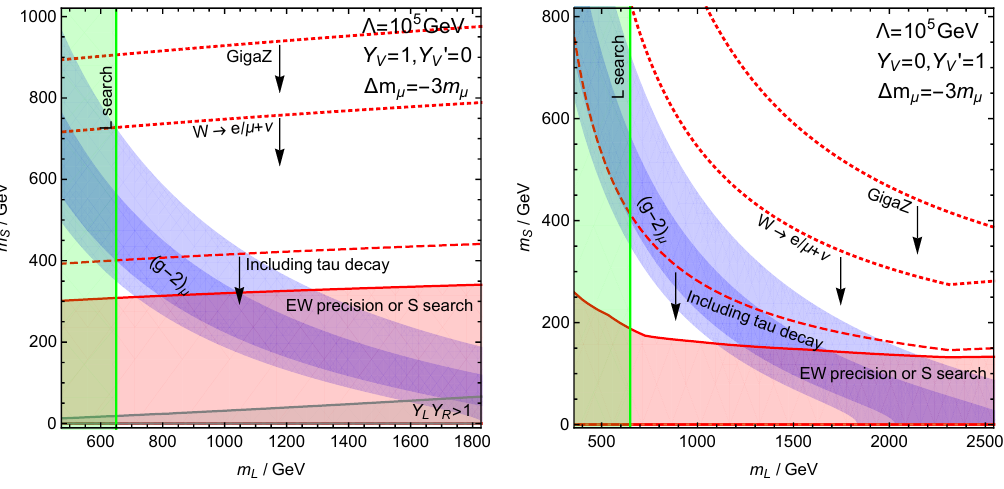
Figure 6 . Constraints on the model for a fixed ∆ m µ = − 3 m µ